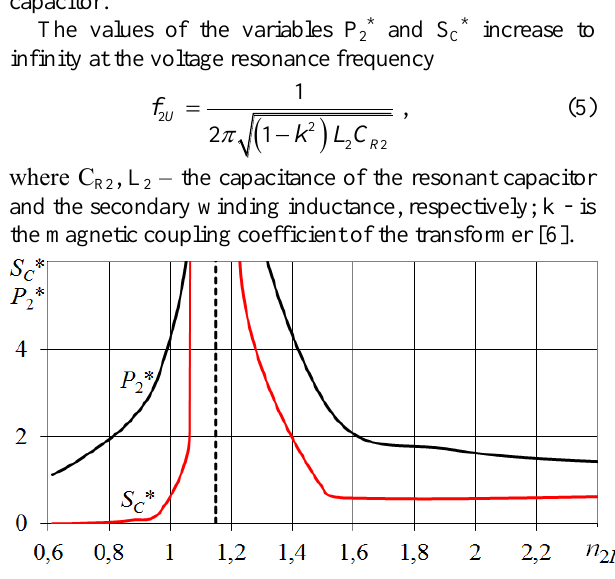
Figure 7. System secondary circuit frequency characteristic with series connection of the resonant